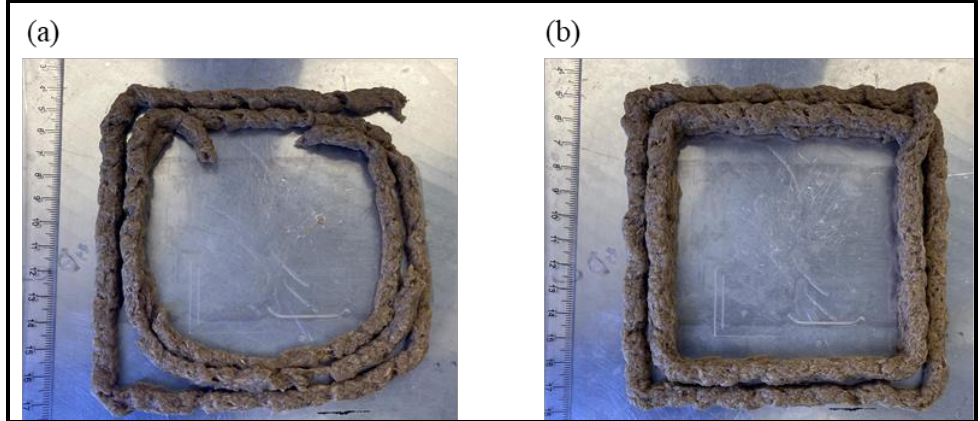
Figure 6. Printed samples by ( a ) discontinuous extrusion and ( b ) continuous